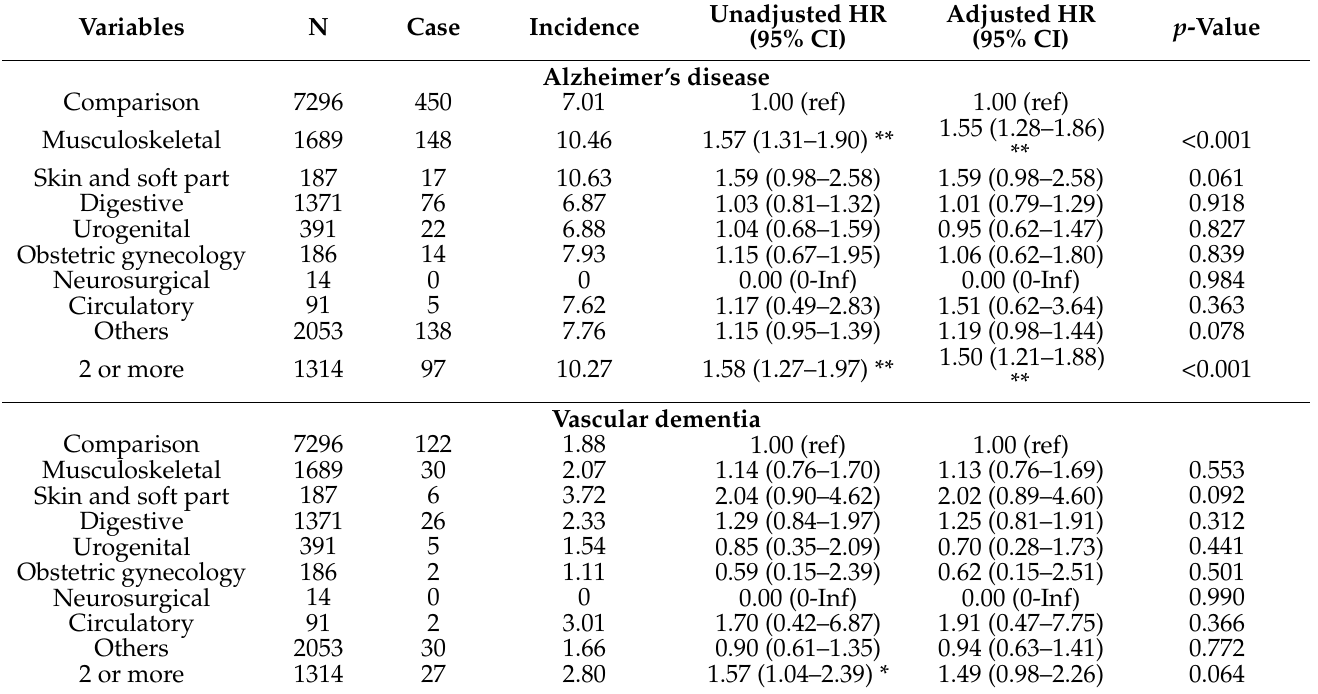
Table A5. Incidence per 1000 person-years and HR (95% CI) of specific diseases (Alzheimer’s disease and vascular dementia) according to the surgical